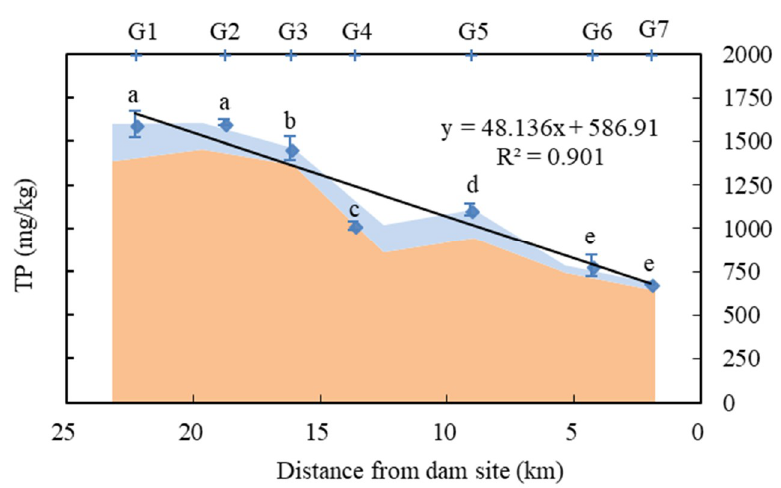
Figure 2. The concentration of phosphorus at each sampling site. The squares represent total phosphorous (TP) values, which are shown as means ± SD ( n = 4). The letters above the squares indicate the results from a post hoc multiple comparison test (least-significant difference test); mean values that do not share a common lowercase letter are significantly different ( p < 0.05). The area in orange represents IP, and that in light blue represents OP.